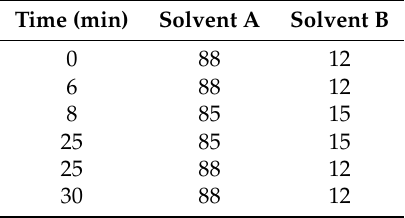
Table 4. Solvent system of anthocyanin analysis using HPLC. Time (min) Solvent A Solvent B 0 88 12 6 88 12 8 85 85